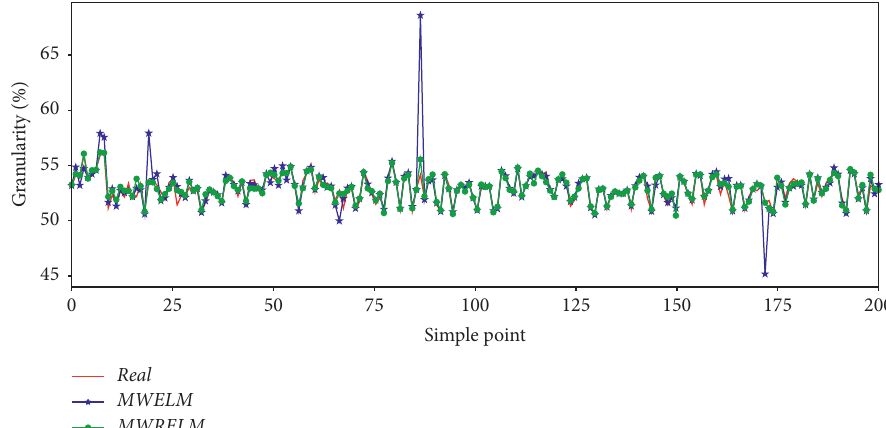
Figure 14: Prediction results under MW-ELM model and MW-RELM model. (a) Prediction results under different soft-sensor models. (b) Prediction errors under different soft-sensor models. (c) Predicted scatter plots under different soft-sensor